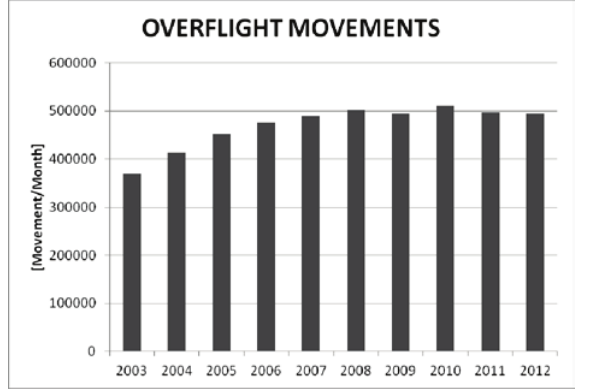
fig. 3. Yearly overflight movements (Source: own edition based on Hungaro Control Data)